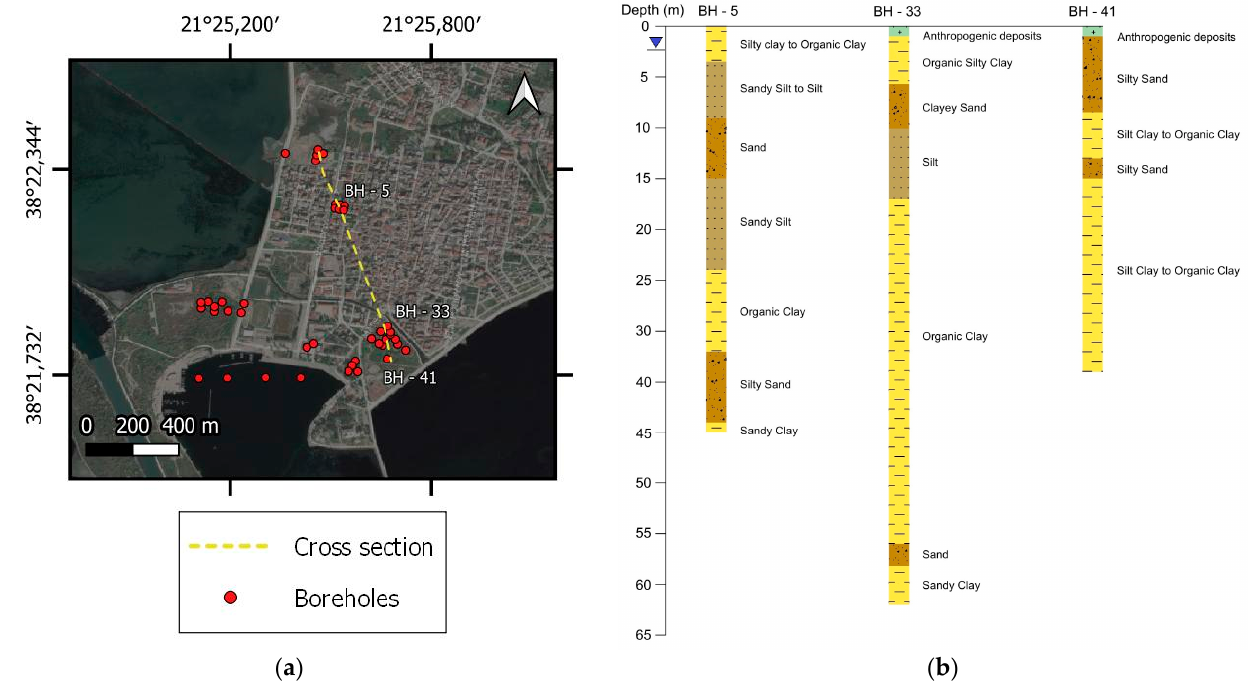
Figure 4. ( a ) Geotechnical borehole locations in Messolonghi ( b ) Indicative logs along the cross section of ( a ).